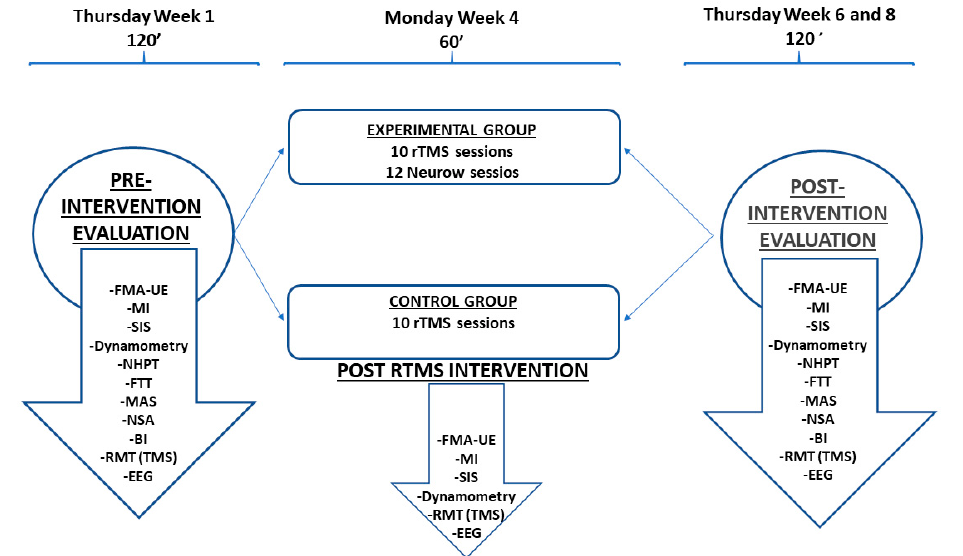
Figure 2. Schematic representation of intervention protocol. It includes the days of the week and duration of each block of outcomes measurement in pre- and post-evaluation (FMA-UE—Fugl-Meyer Assessment for upper extremity; MI—Mo- tricity Index; SIS—Stroke Impact Scale; RMT—Resting Motor Threshold; NHPT—Nine Hole Peg Test; FTT—Finger Tap- ping Task; MAS—Modified Asworth Scale; NSA—Nottingham Sensory Assessment; BI—Barthel Index; EEG—Electroen- cephalogram. Thursday/90–120 min; Monday/60 min; Control Intervention/Monday to Friday/10 rTMS sessions and Ex- perimental Intervention: Monday to Friday/10 rTMS sessions and Monday, Wednesday, and Friday/12 NeuRow